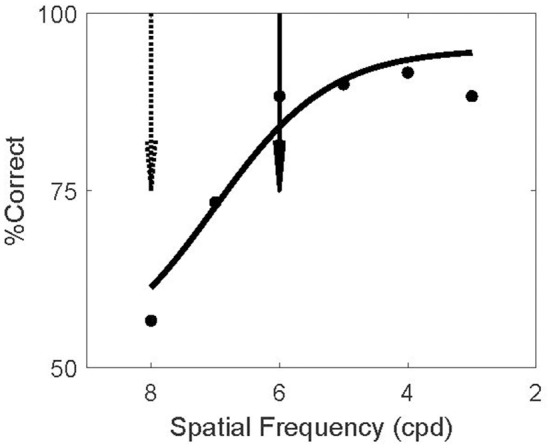
Screening Invisible Adapters. Psychometric curve for a single subject's performance on the screening task. This subject performed near chance for 8 cpd (dashed arrow) and above 80% correct for spatial frequencies above 6 cpd (solid arrow). Solid curve shows a logistic fit to the psychometric data. Based on this screening experiment, this subject's adapter frequency was set to 8 cpd and the test frequency to 6 cpd. Using the notation (8/6) to denote this outcome, two other subjects' screening experiments resulted in the same frequency setting outcome (8/6), four subjects had (7/4), and one subject had (6/4).